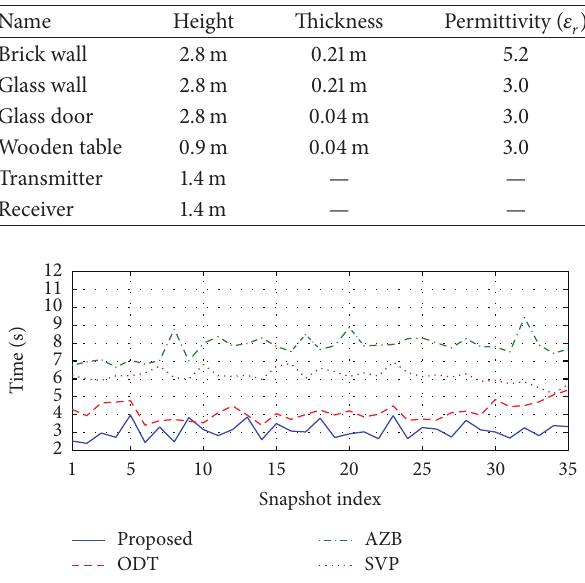
Figure 13: Comparison of ray tracing time between the proposed and existing ray tracing